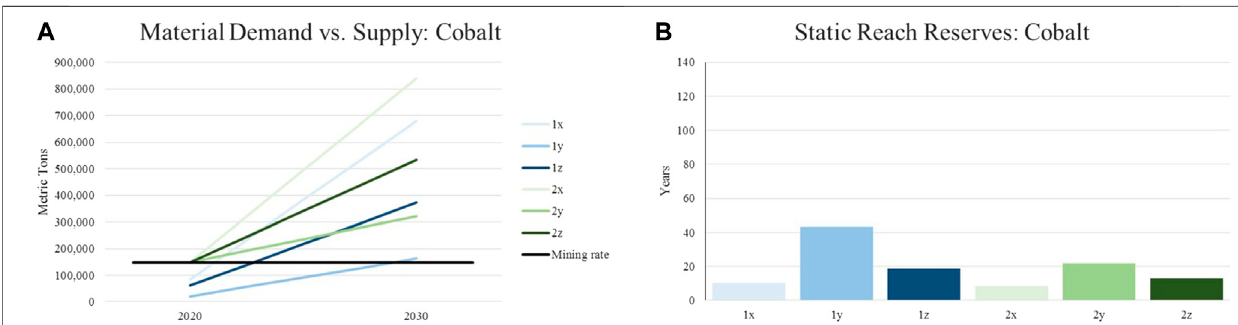
FIGURE 6 | Analysis of cobalt raw material availability.